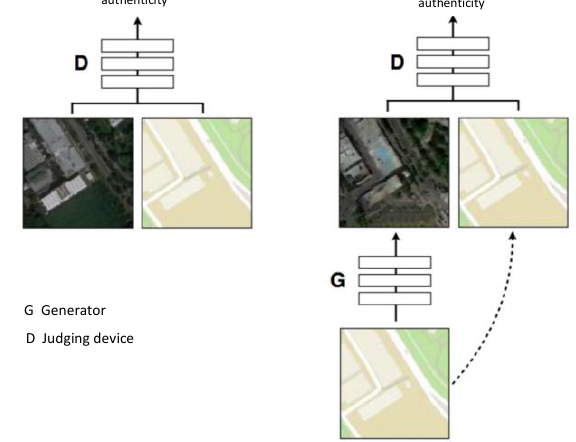
Figure 5. Training process of remote sensing image conversion network map.